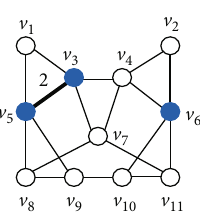
Figure 7: Optimal domination